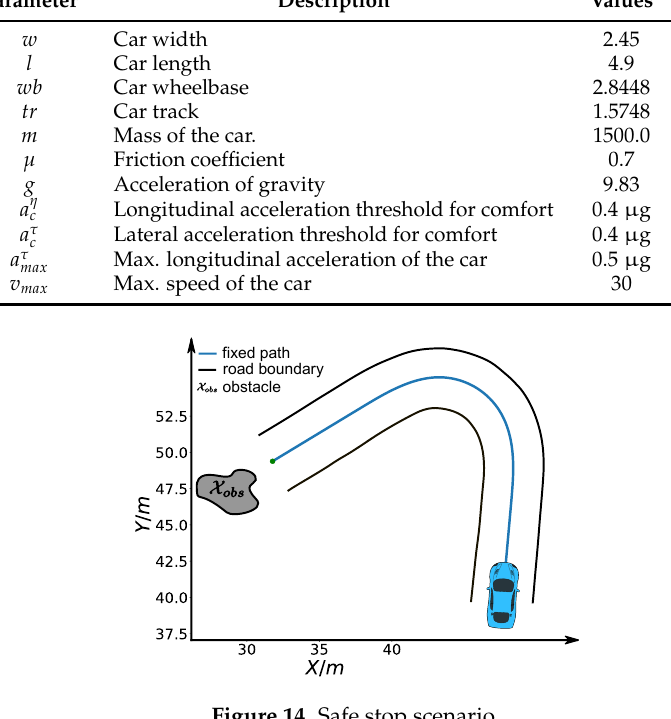
Figure 14. Safe stop scenario.